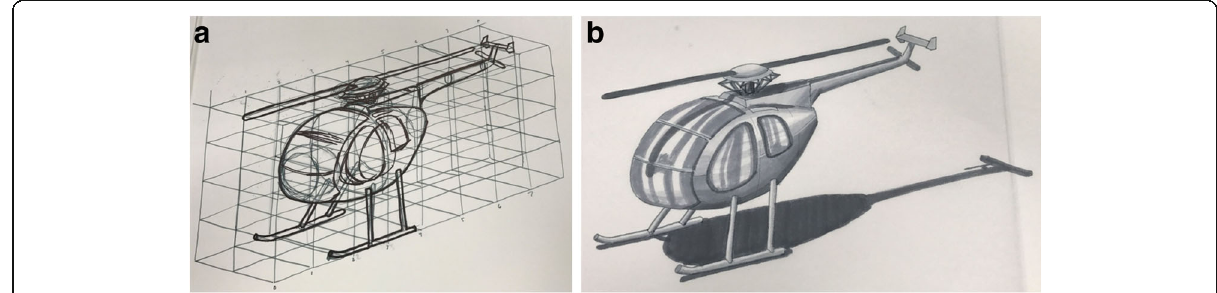
Fig. 2 Student submission for lab assignment requiring a sketch in perspective view. a Draft sketch with scaffolding. b Final composition sketch with shading and